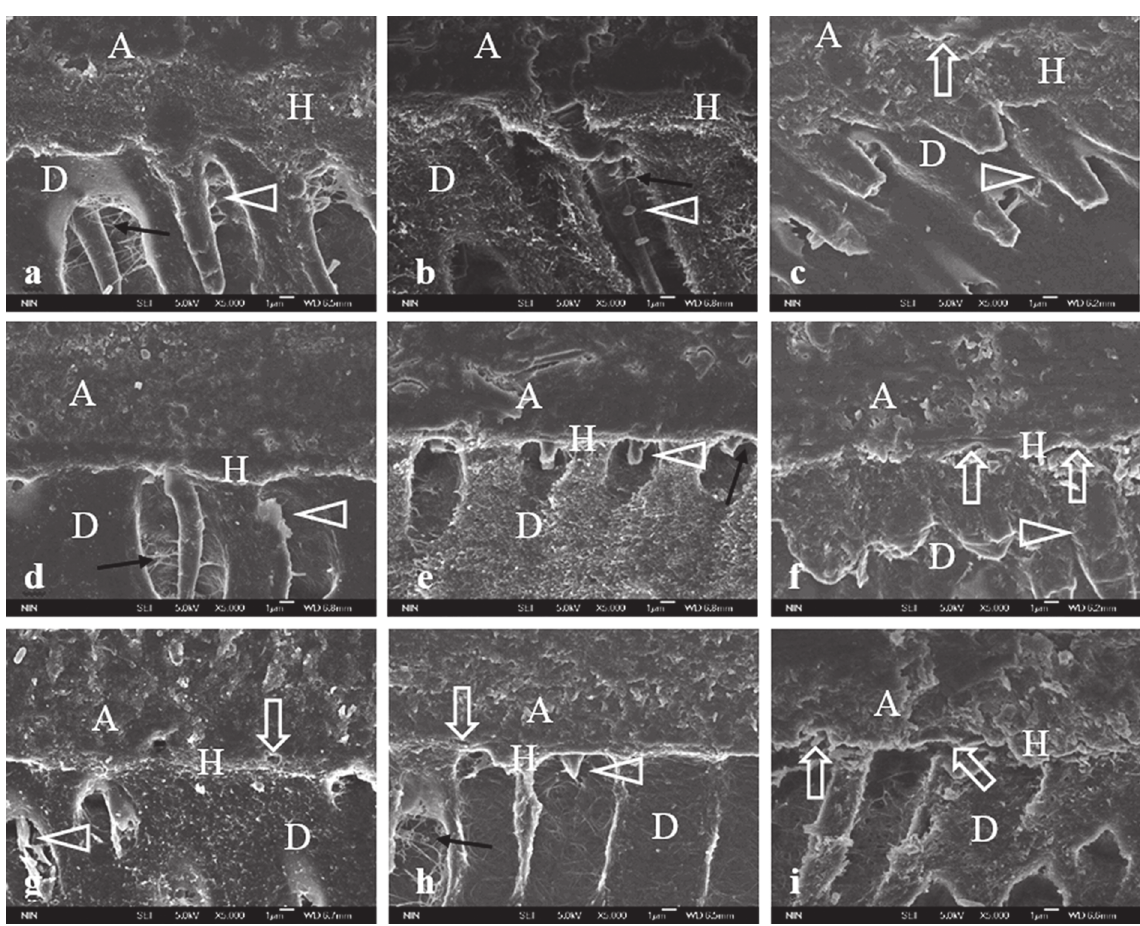
Fig 2. FEISEM micrographs of the hybrid layer. (×5 000). A = adhesive; H = hybrid layer; D = underlying mineralized dentin. a, b, c stand for dentin-SB interface without aging, aged for 1 m and aged for 4 m respectively. d, e, f stand for dentin-SEB interface without aging, aged for 1 m and aged for 4 m respectively. g, h, i stand for dentin-SEB interface without aging, aged for 1 m and aged for 4 m respectively. The non-uniform thick hybrid layer with long resin tags (open arrowhead) are clearly seen. There are lots of resin tags pointing to the lateral wall of the tubule with collagen fibril emanating from the resin surface (black arrow) (Fig. 2A). No visible gaps can be detected. There are fewer and shorter resin tags (open arrowhead) which interact with collagen fibrils pointing to the lateral wall of the tubule (black arrow) (Fig. 2B). Slight cracks (arrow) can be seen within the hybrid layer. Despite of large quantities of resin tags (open arrowhead) infiltrating into dentin tubules, no lateral branch of resin tags can be found (Fig. 2C). The hybrid layer is compact with numerous long resin tags permeate into the dentin tubules. There are fewer lateral branch of resin tags (open arrowhead). However, the main part of resin tags (black arrow) interacting with collagen is evident (Fig. 2D). Compact and homogenous hybrid layer with a great deal of resin tags (open arrowhead) are clearly detected. Resin tags are winded around by collagen fibrils (black arrow) (Fig. 2E). The structure of hybrid layer is non-uniform, while a great number of resin tags (open arrowhead) permeated into the dentin matrix. Cracks (arrows) along hybrid layer can be clearly detected (Fig. 2F). There are a few porous defects (arrow) within the certain part of hybrid layer. Resin tags, some of which are fractured (open arrowhead), can be clearly observed in the dentin tubules (Fig. 2G). Some porous defect (arrow) can be observed. There are short resin tags infiltrating into the dentin tubules (open arrowhead), collagen fibril under the hybrid layer (black arrow) (Fig. 2H). There is no clear boundary of the hybrid layer and the whole interface exhibited an inhomogeneous morphology with evident cracks (arrows). The dentin tubules were empty and no resin tags can be found (Fig.